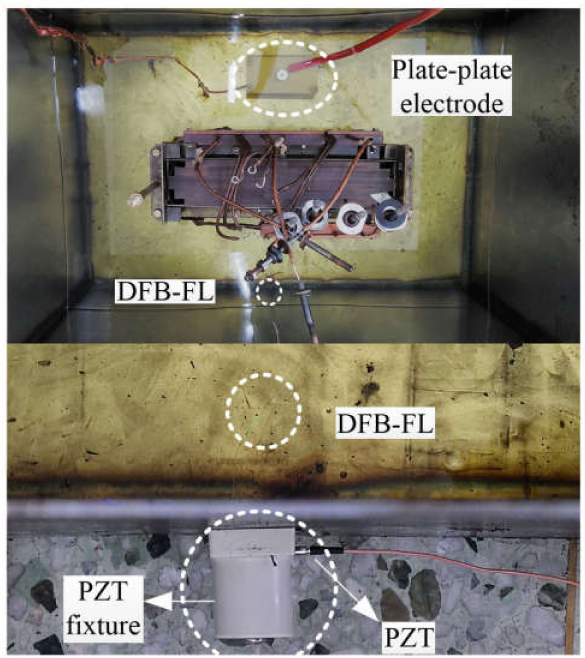
Figure 3. Experimental platform and install location of sensors. (The upper section shows the vertical view of the oil tank, and the bottom shows the installation distance between DFB-FL and PZT).